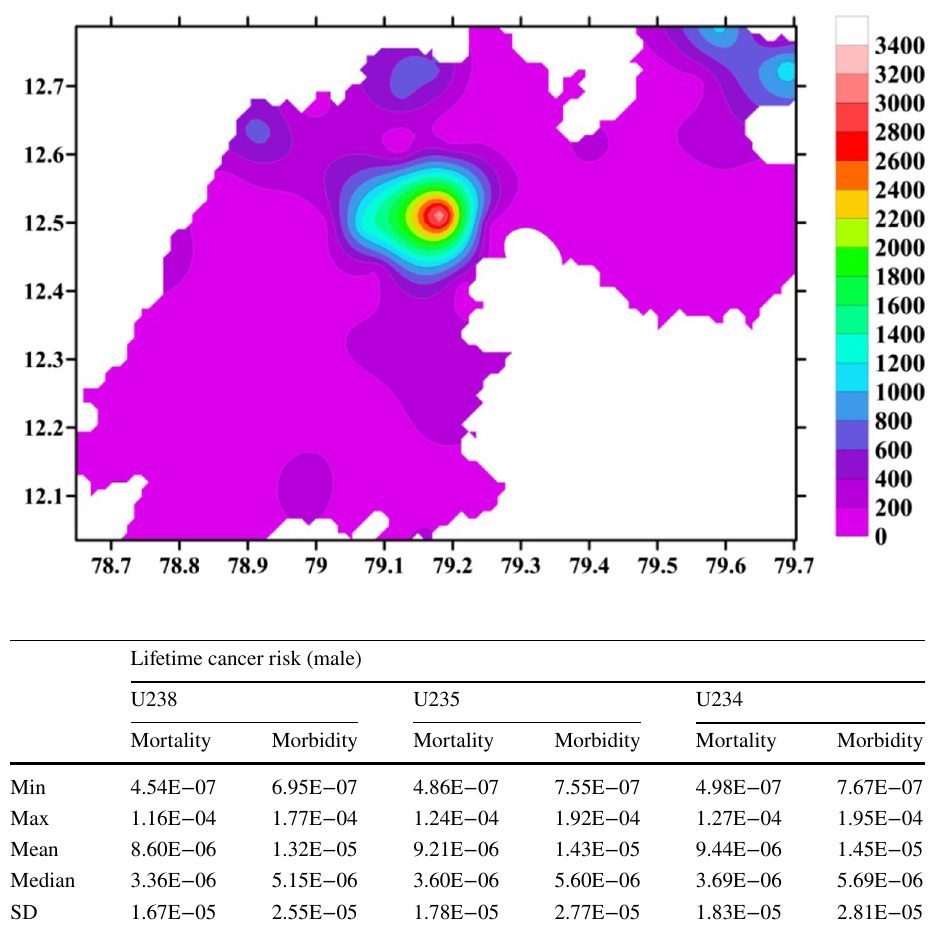
Fig. 25 Spatial variation of cumulative whole body dose in adult